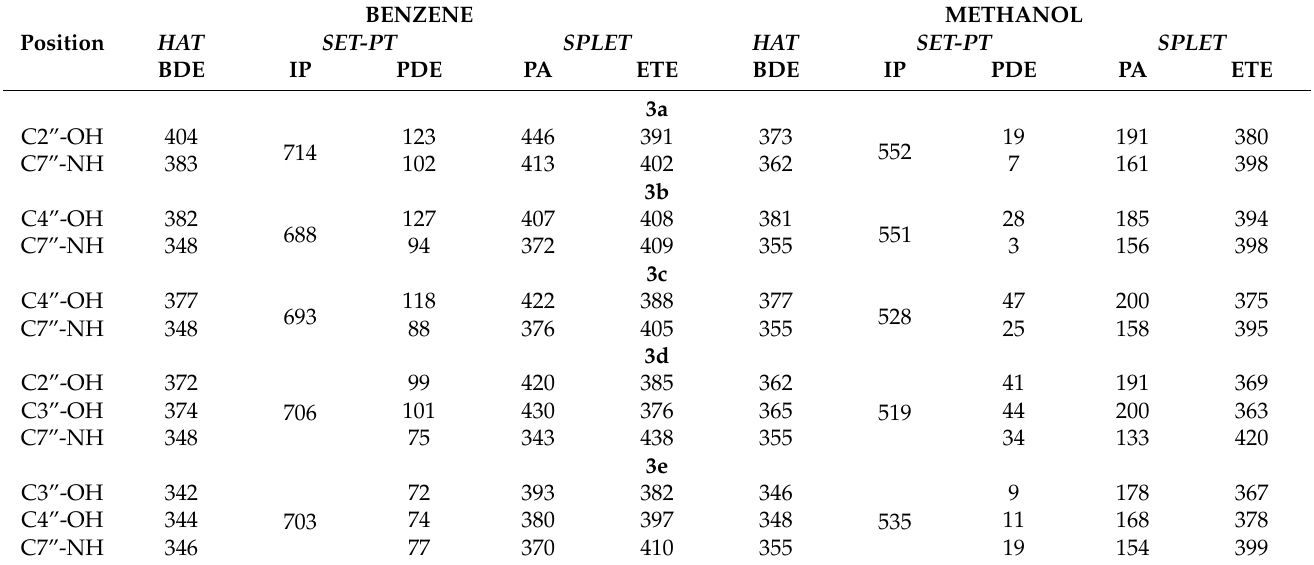
Table 3. Thermodynamic parameters of antioxidant mechanism for investigated coumarin-hydroxybenzohydrazide derivatives in kJ moL − 1 . BENZENE METHANOL Position HAT SET-PT SPLET HAT